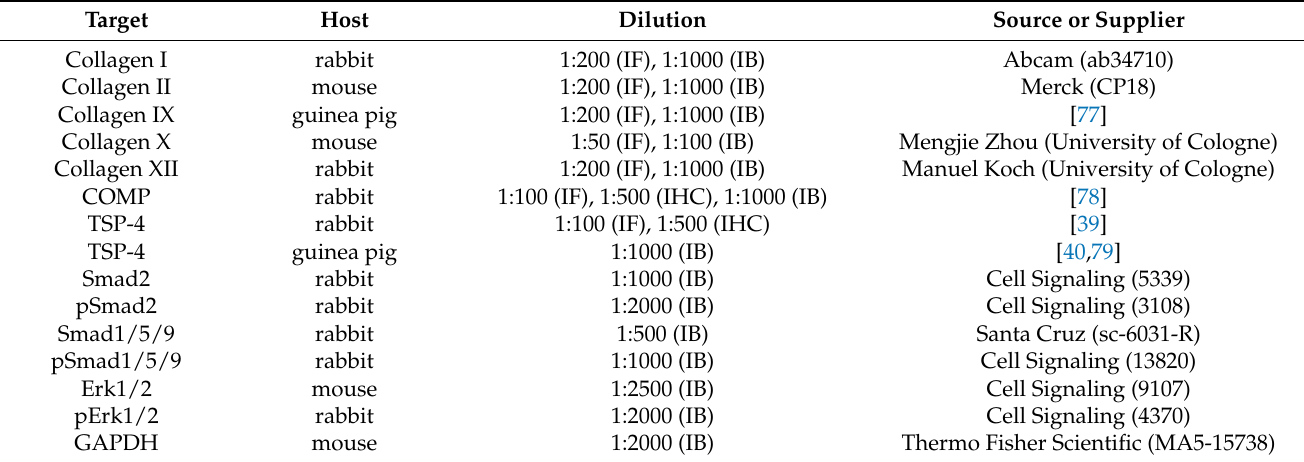
Table 1. List of primary